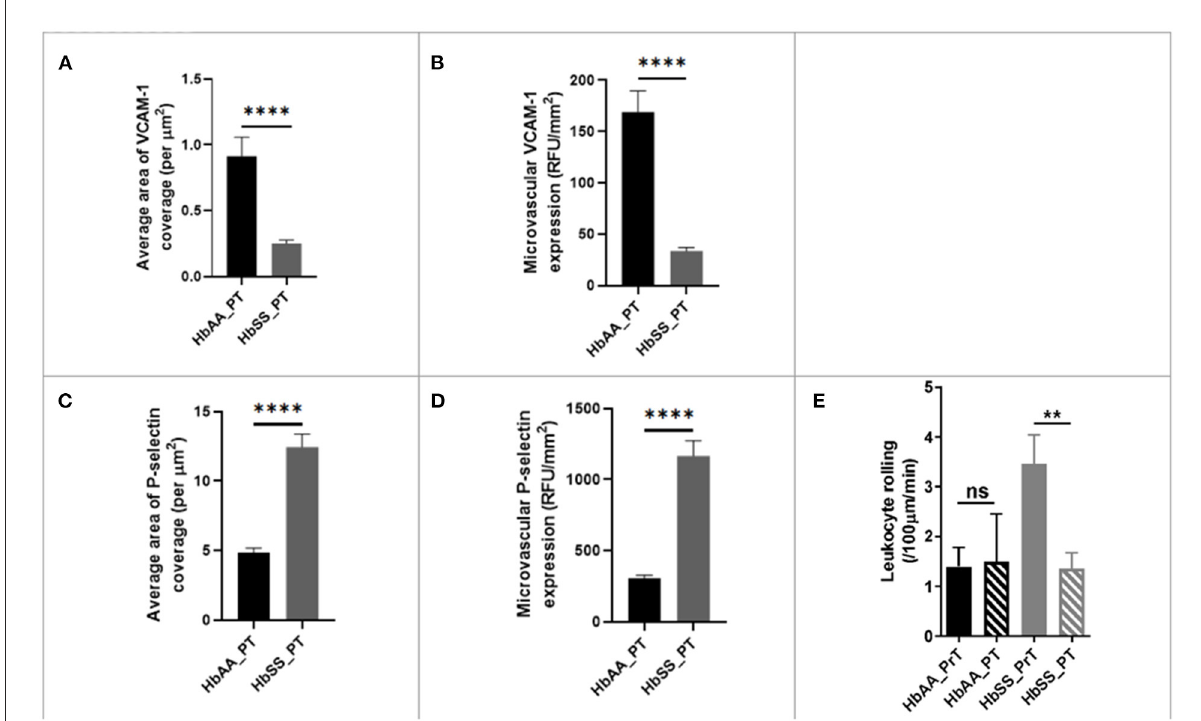
FIGURE6 Blood transfusion improves cerebral vascular endothelium in sickle cell mice. (A) Average area of VCAM-1 coverage per µ m 2 in AA mice compared to SS. (B) Microvascular VCAM-1 expression in RFU/mm 2 in AA mice compared to SS. (C) Average area of P-selectin coverage per µ m 2 ( p < 0.0001). (D) Microvascular P-selectin expression (RFU/mm 2 ). (E) Leukocyte adherence in AA and SS mice pre- and post-transfusion. AA: n = 3–5; SS: n = 5-7. Error bars are SEM. NS, Not significant; ** p ≤ 0.01; **** p ≤ 0.0001. Mean comparisons done using Welch’s corrected t -test. For VCAM-1 analysis, AA = 73 brain slices and SS = 147 brain slices, while for P-selectin analysis, AA = 162 brain slices and SS = 164 brain slices. For leukocyte rolling, AA = average of ∼ 73 vessel segments pre-transfusion and 23 vessel segments post-transfusion; SS = average of ∼ 90 vessel segments pre-transfusion and 54 vessel segments